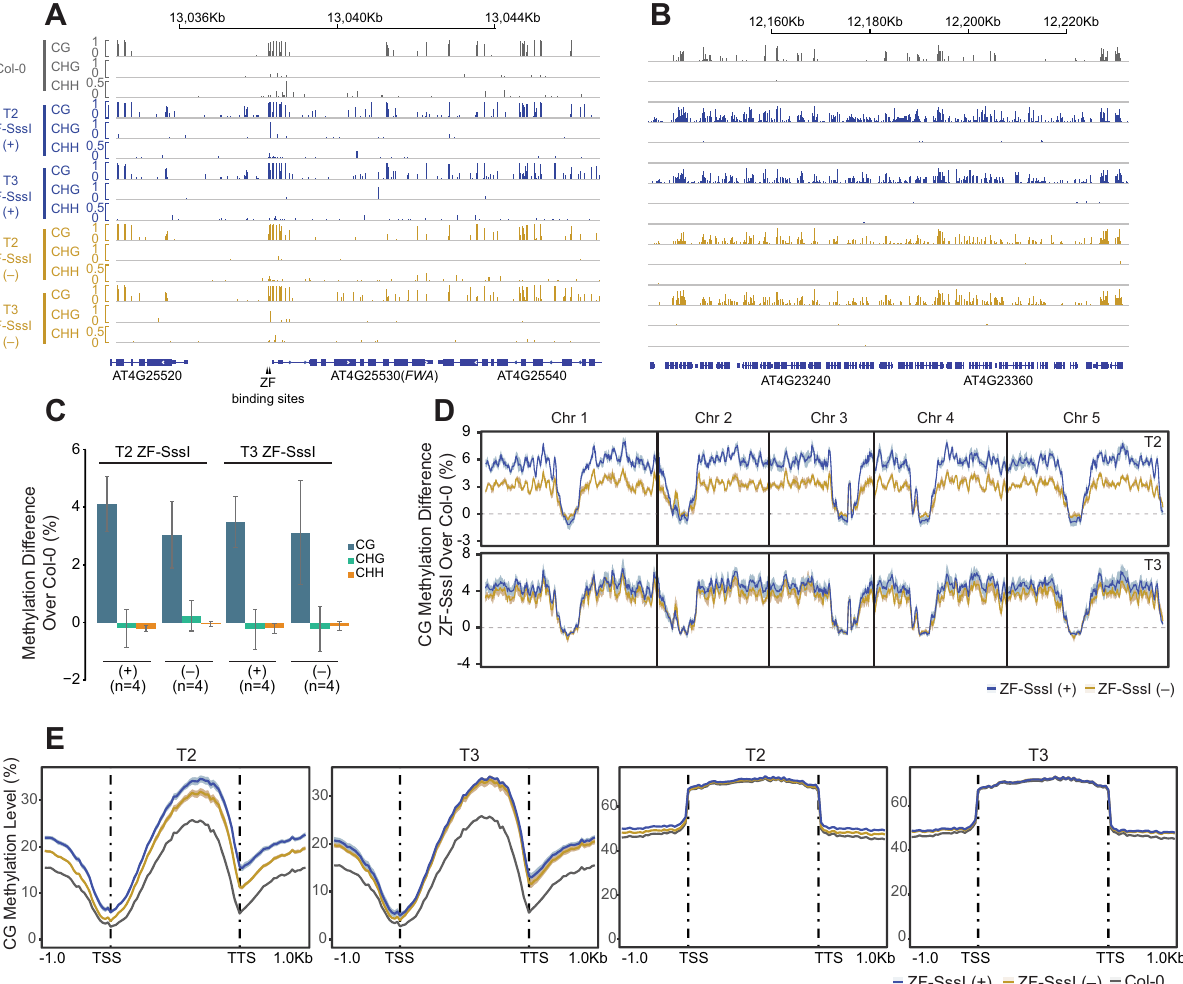
Fig. 2 SssI-targeted genome-wide heritable CG methylation. A Screenshot for CG, CHG, and CHH methylation of representative ZF-SssI lines during T2 and T3 with ( + ) or without ( ‒ ) the transgene in Col-0 background over the FWA locus. Each bar represents a single base-pair. Black triangles indicate the designed ZF binding sites. B Screenshot for CG, CHG, and CHH methylation of representative ZF-SssI lines during T2 and T3 with ( + ) or without ( ‒ ) the transgene in the Col-0 background over a selected genomic region. C Barplot of genome-wide CG, CHG, and CHH methylation difference for ZF-SssI lines during T2 and T3 with ( + ) or without ( ‒ ) the transgene over Col-0. Error bars represent standard errors, center of error bars represent mean. D Genome- wide metaplot of CG methylation for ZF-SssI lines during T2 and T3 with ( + ) or without ( ‒ ) the transgene. The curve represents the mean, shaded area around the curve represents standard errors ( n = 4). E CG methylation metaplot for Col-0 and ZF-SssI lines during T2 and T3 with ( + ) or without ( ‒ ) the transgene over protein-coding genes (left two panels) or transposable elements (TEs) (right two panels). The curve represents the mean, shaded area around the curve represents standard errors ( n =